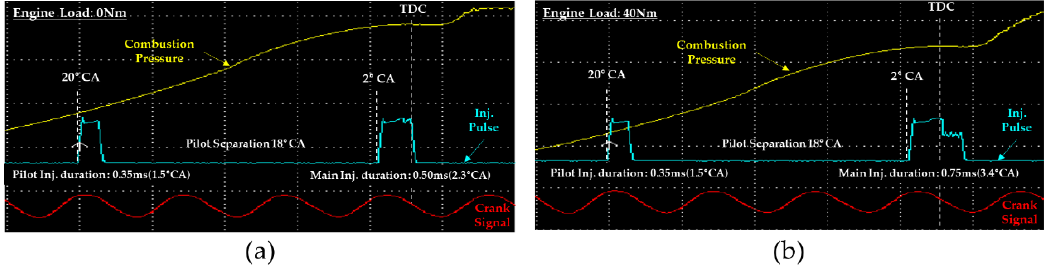
Figure 3. Injection timings and durations at engine loads: ( a ) 0 Nm, and ( b ) 40 Nm.